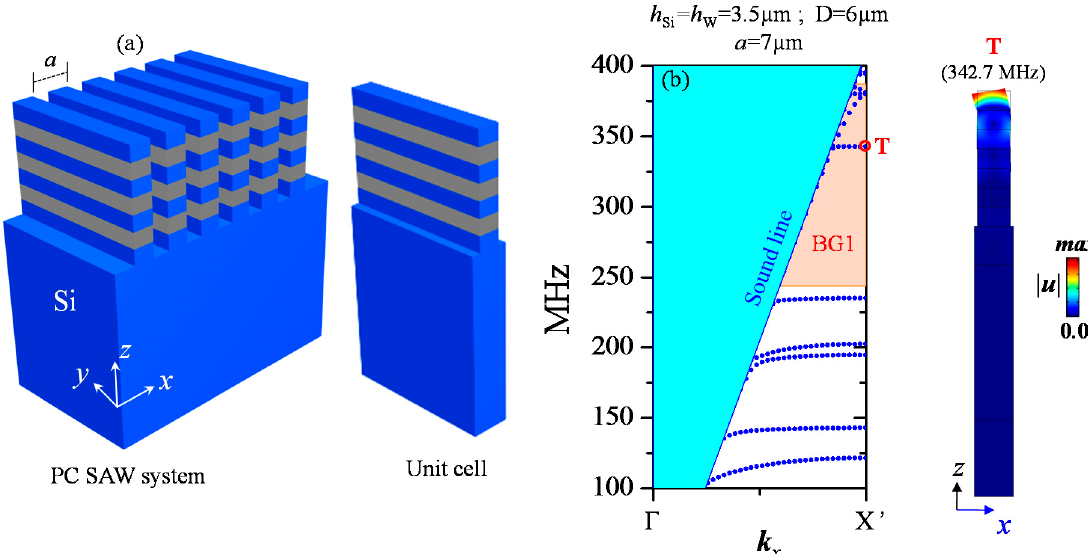
Figure 2. ( a ) Phononic crystal (PC) structure made of periodic phononic ridges on Si substrate surface along x direction. ( b ) Band structure of the PC system for surface acoustic wave (SAW) propagation along x direction. The orange shaded region corresponds to the band gap BG1 of the phononic ridge. (Right) Total displacement field amplitude in the unit cell for mode denoted T in the band structure.